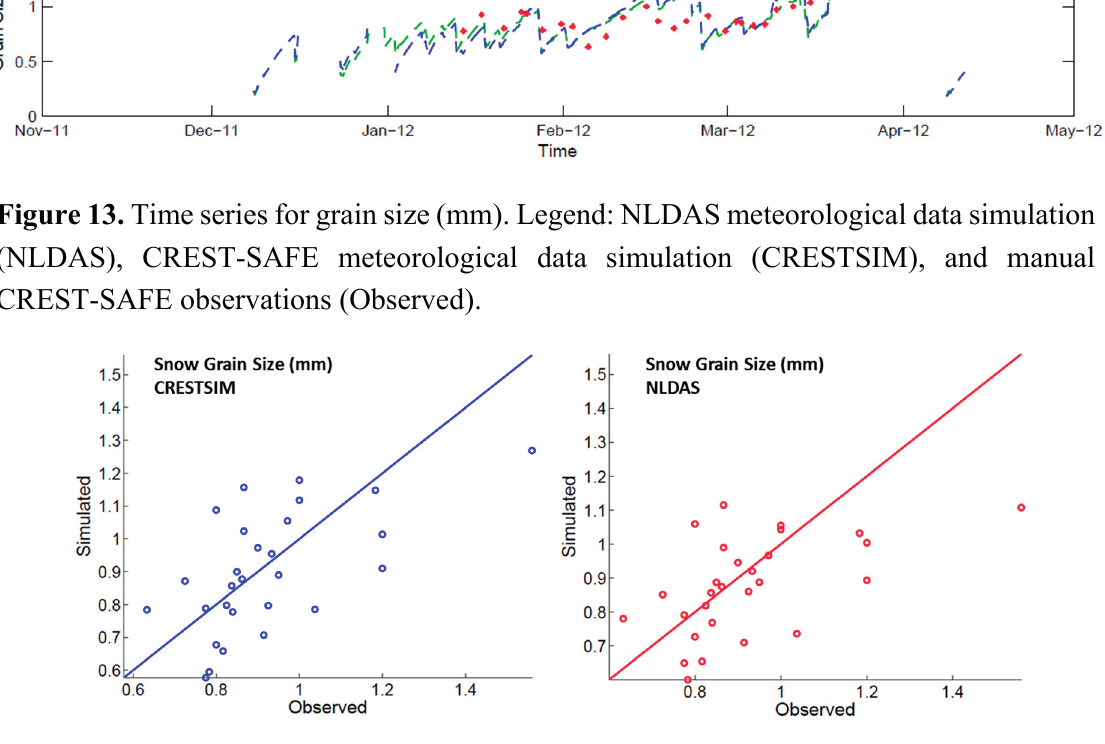
Figure 14. Snow grain size scatter plot (winter 2011–2012) for both simulated scenarios: ( left ) CRESTSIM; and ( right )